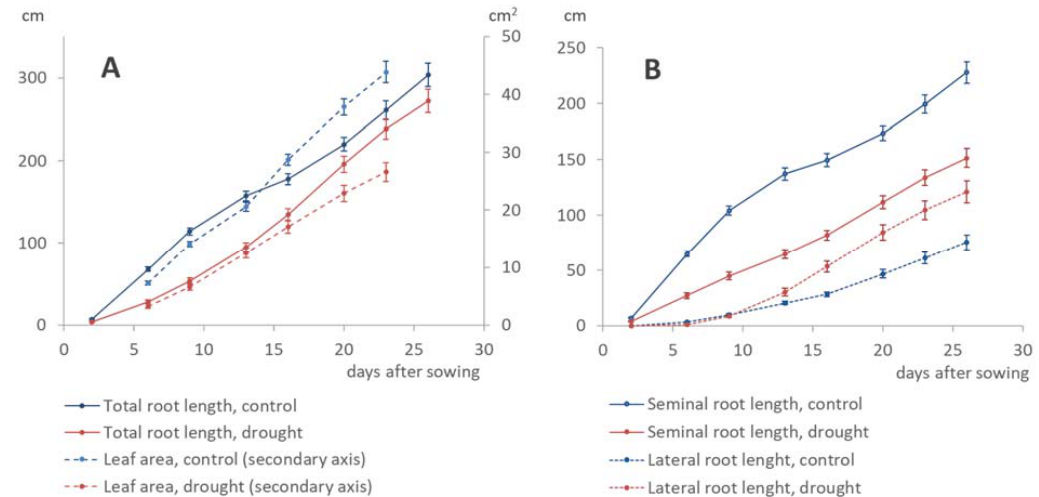
Figure 2. Dynamics of growth of roots and leaves during the duration of the experiment, averaged over genotypes, for the control and drought conditions (bars represent ± standard errors of the means). ( A ) Total root length averaged (primary axis) and total leaf area (secondary axis). ( B ) Seminal and lateral root lengths.